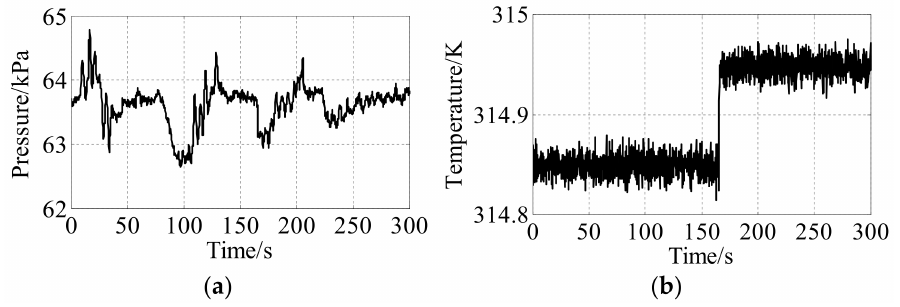
Figure 16. Outlet conditions of variable cross section pipe. ( a ) Pressure outlet conditions; ( b ) Temperature outlet conditions.